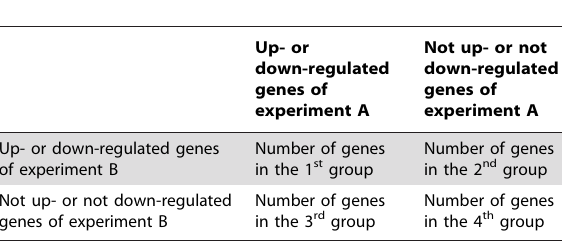
Table 2. CU-DREAM 2 6 2 table of chi-square